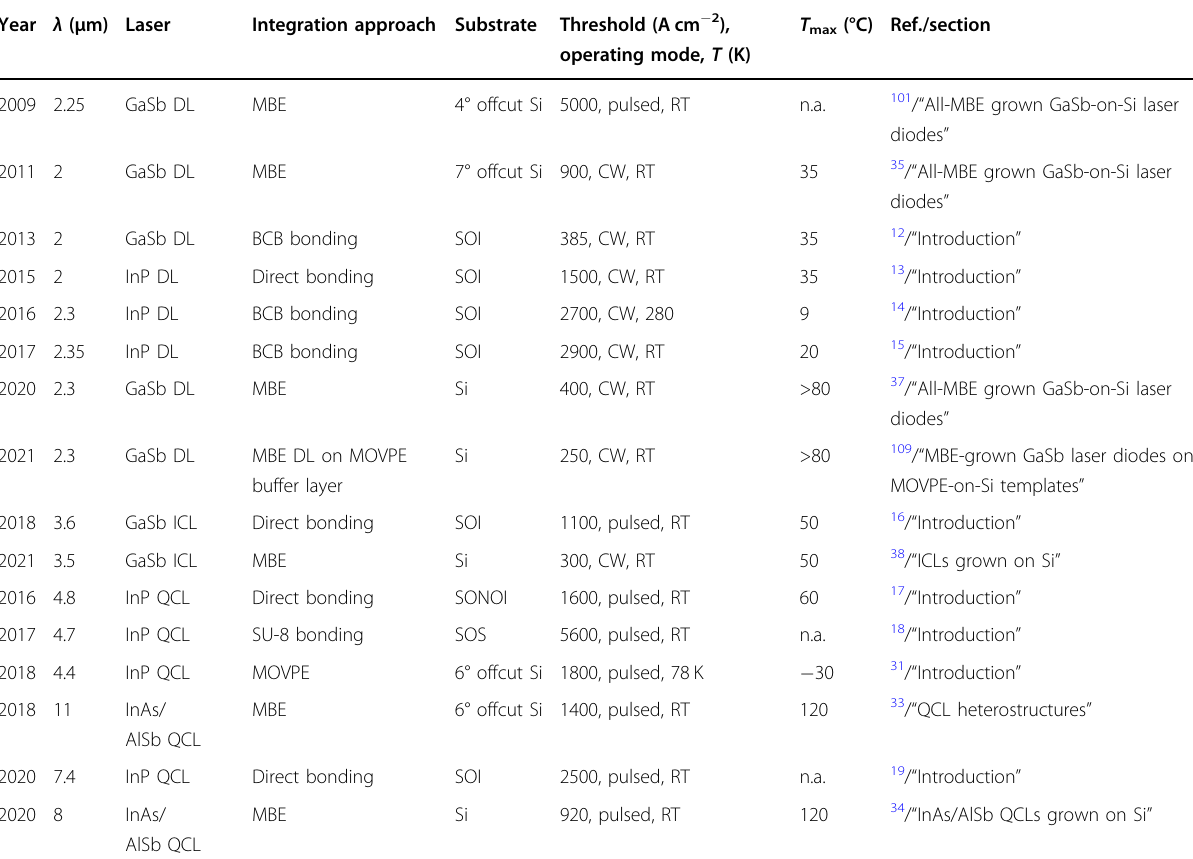
Table 1 Literature data for mid-IR lasers ( λ ≥ 2 µm) integrated on silicon substrates, organized chronologically by laser